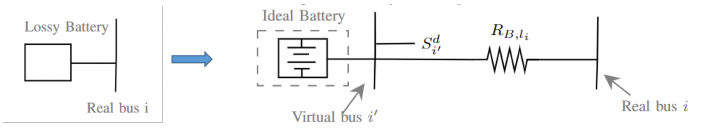
Figure 2. Resistance-line model of the